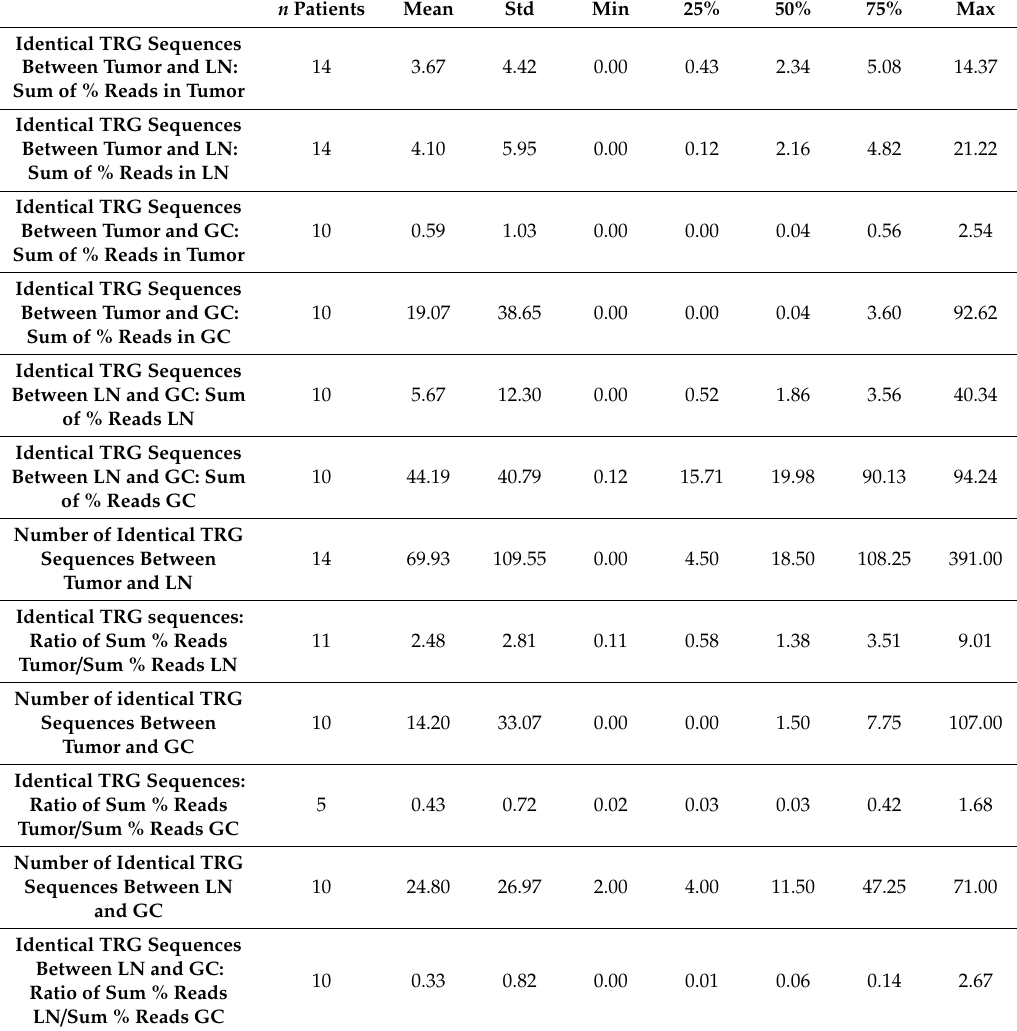
Table 4. Descriptive statistics of T-cell receptor gamma (TRG) sequences of the CDR3 region measurements in the tumor, the draining LNs, and the GCs of these